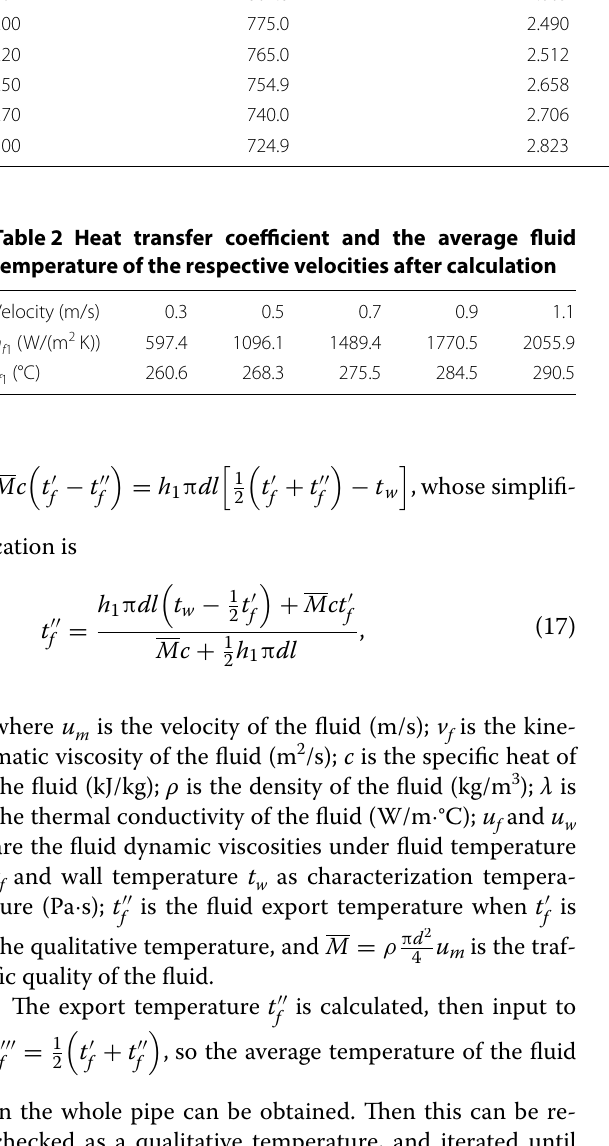
Table 2 indicates the heat transfer coefficient and average fluid temperature of the respective velocities after calculation.